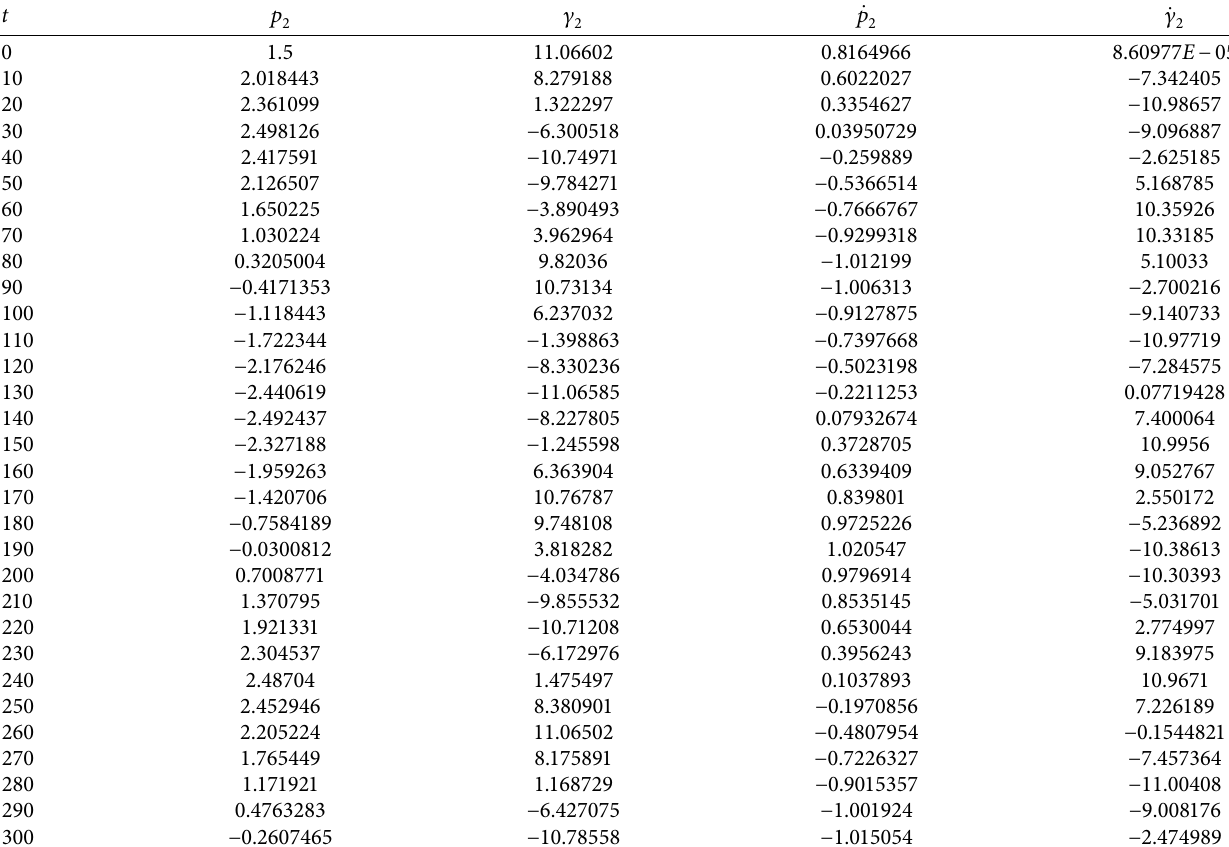
, c , and their derivatives. 2 2